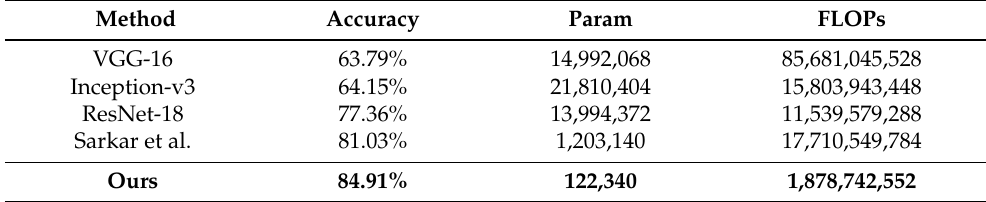
Table 5. On Bi-Modal datasets, the result present as